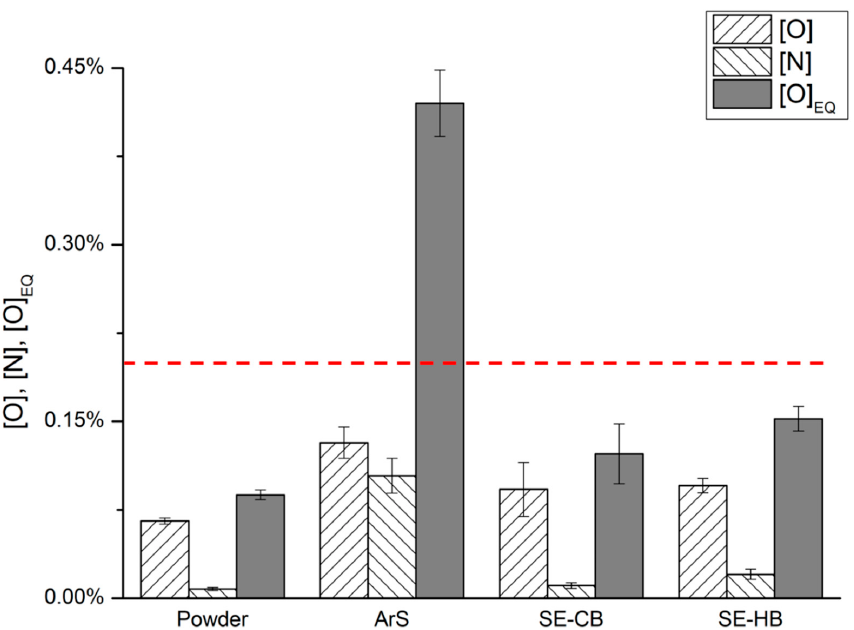
Figure 5. Oxygen and nitrogen concentration evaluated for the samples built in all the considered environment and relative [O] EQ evaluation. The 0.22% threshold is highlighted in red.